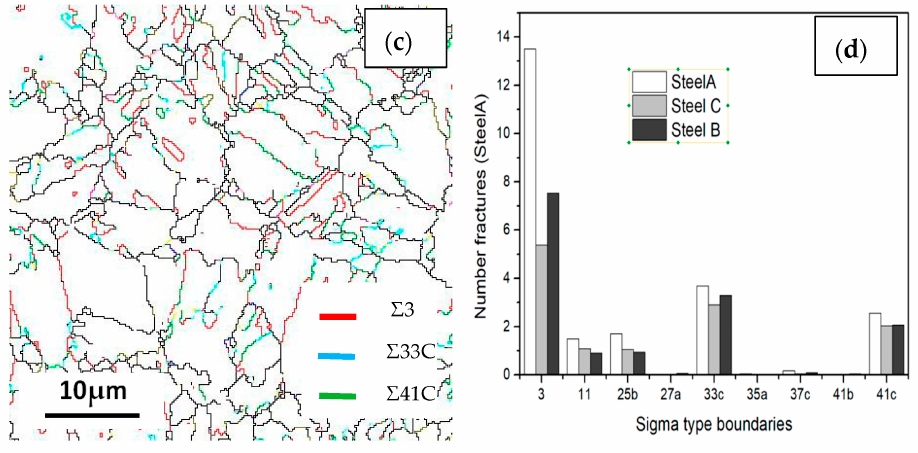
Figure 14. Coincidence site lattice (CSL) of the ( a ) steel A, ( b ) steel B and ( c ) steel C specimens; and ( d ) the histograms showing their LAGBs and HAGBs number fractions.